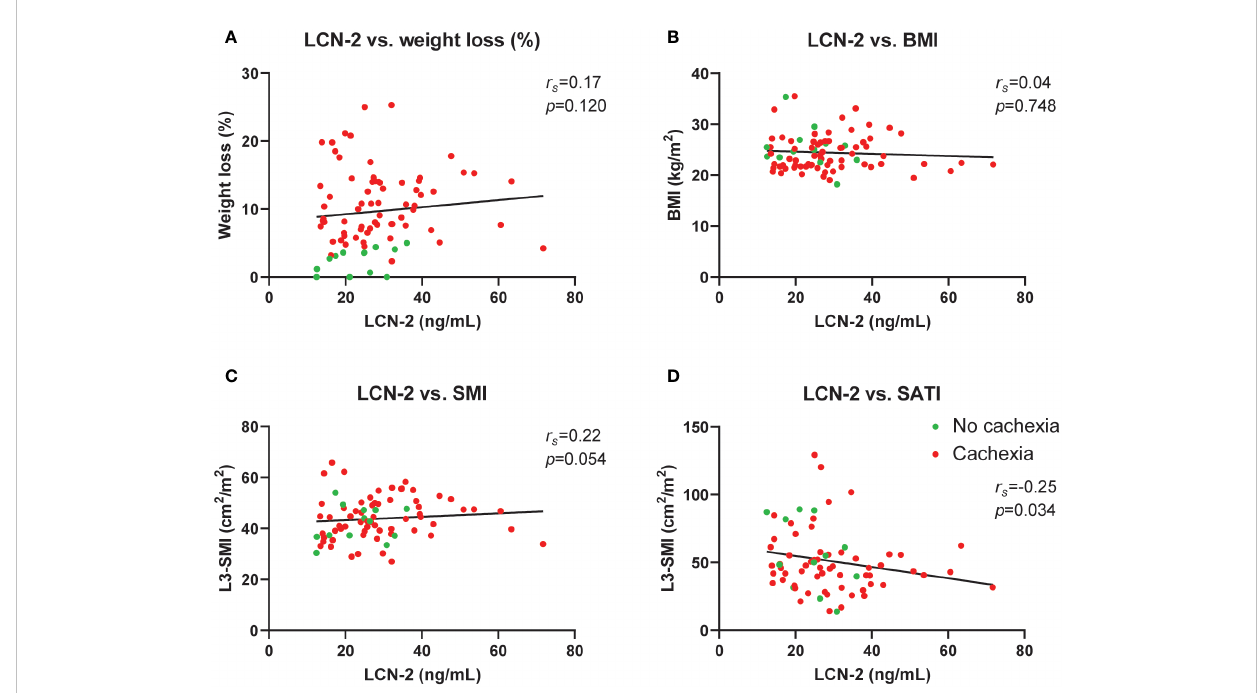
FIGURE 5 Circulating LCN-2 levels do not correlate with cachexia features in pancreatic cancer patients. Correlation analysis between circulating LCN-2 levels and cachexia features weight loss (%) (A) , body mass index (B) , skeletal muscle index (n=80) (C) , as well as subcutaneous fat index (n=72) (D) . Spearman ’ s rank correlation coef fi cient ( r s ) was used for the relationship between